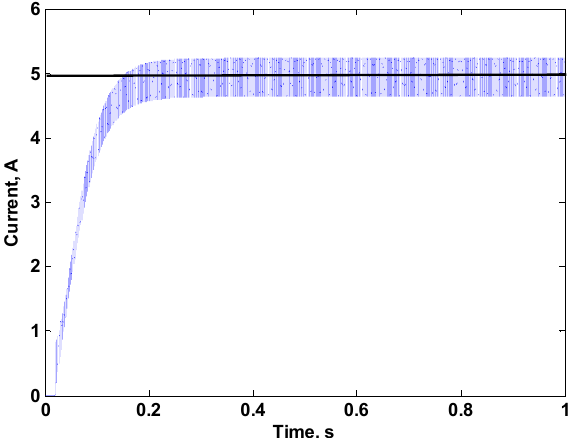
Figure 24. Charging current at a reference current of 5 A.